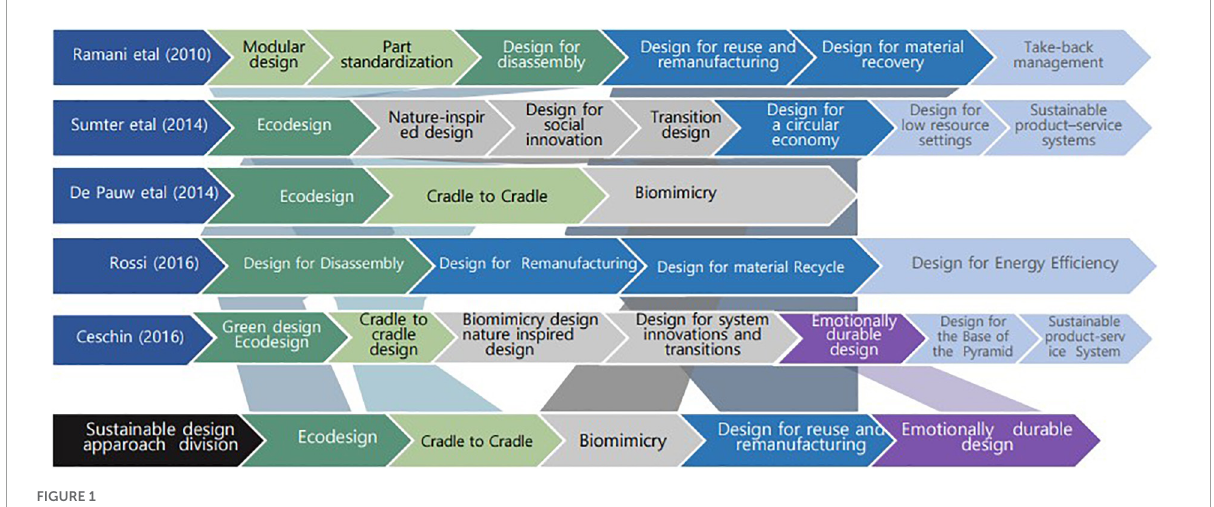
FIGURE1 Process of classifying sustainable design approaches based on previous